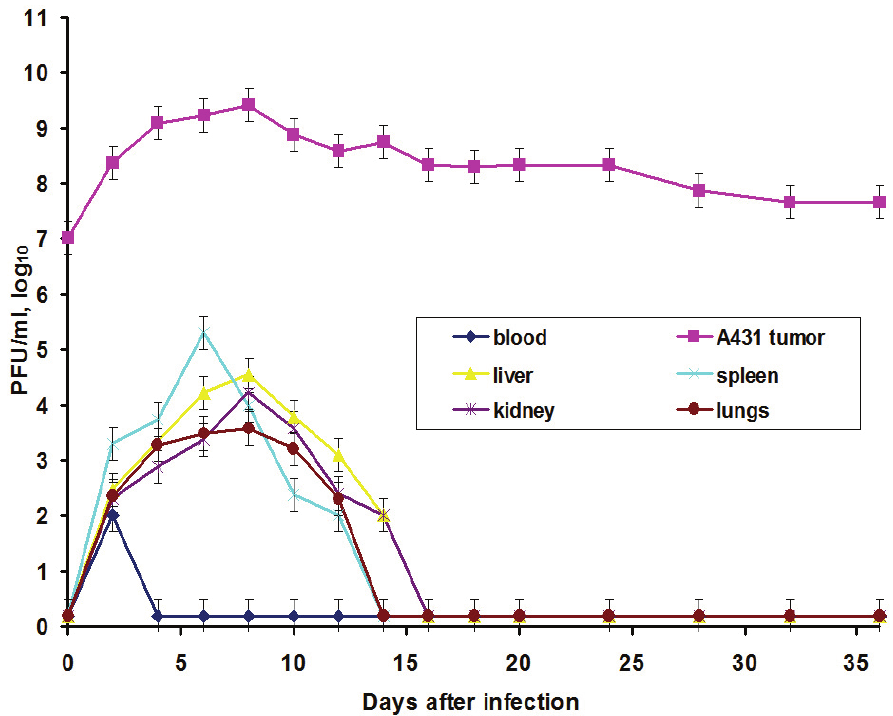
Figure 2. Kinetics of VACV strain L-IVP accumulation in human A431 carcinoma xenografts, blood and visceral organs of nude mice after intratumoral virus injection. The bottom line indicates detection limit of the method (about 10 PFU/mL). Data are presented as mean ± SD.